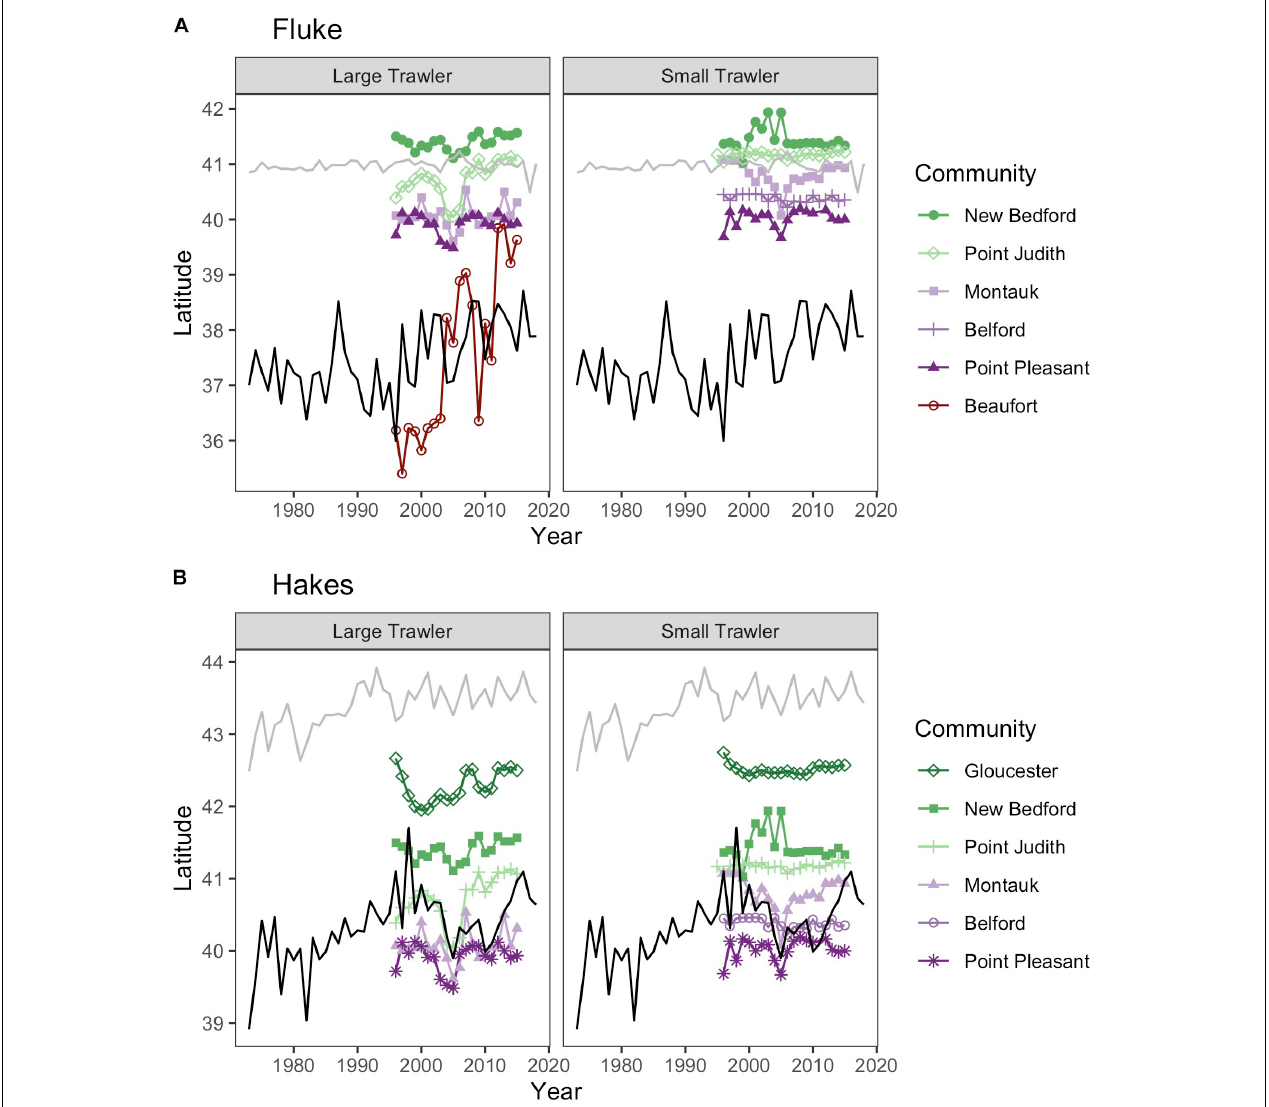
FIGURE 5 | Location of fishing grounds relative to species ranges. Colored lines represent median latitude of fishing trips weighted by fisher days within the NEFSC survey region for (left) small trawl vessels ( < 65 ft) and (right) large trawl vessels ( > 65 ft). The centroids for the fishing grounds are overlaid on the northern (90th quantile of latitude weighted by biomass, gray line) and southern (10th quantile of latitude weighted by biomass, black line) limit for (A) fluke and (B) hakes. Note fishing trip locations were limited to those taking place north of Cape Hatteras, the southern bound of the NEFSC